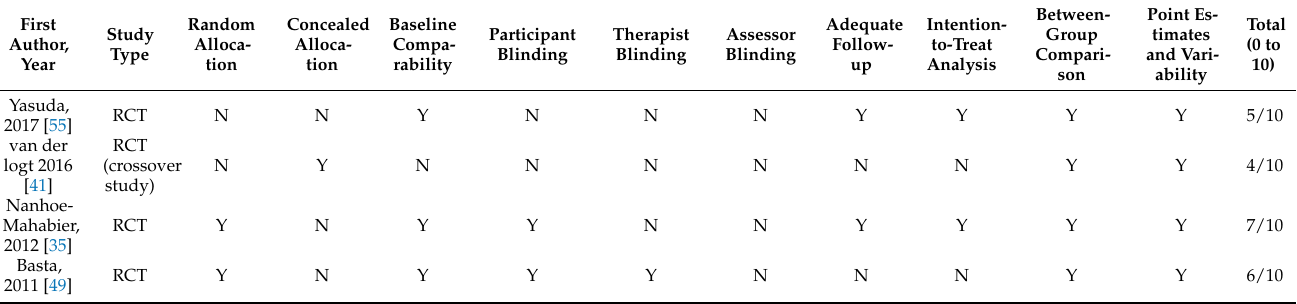
Table 3. PEDro scores of the included